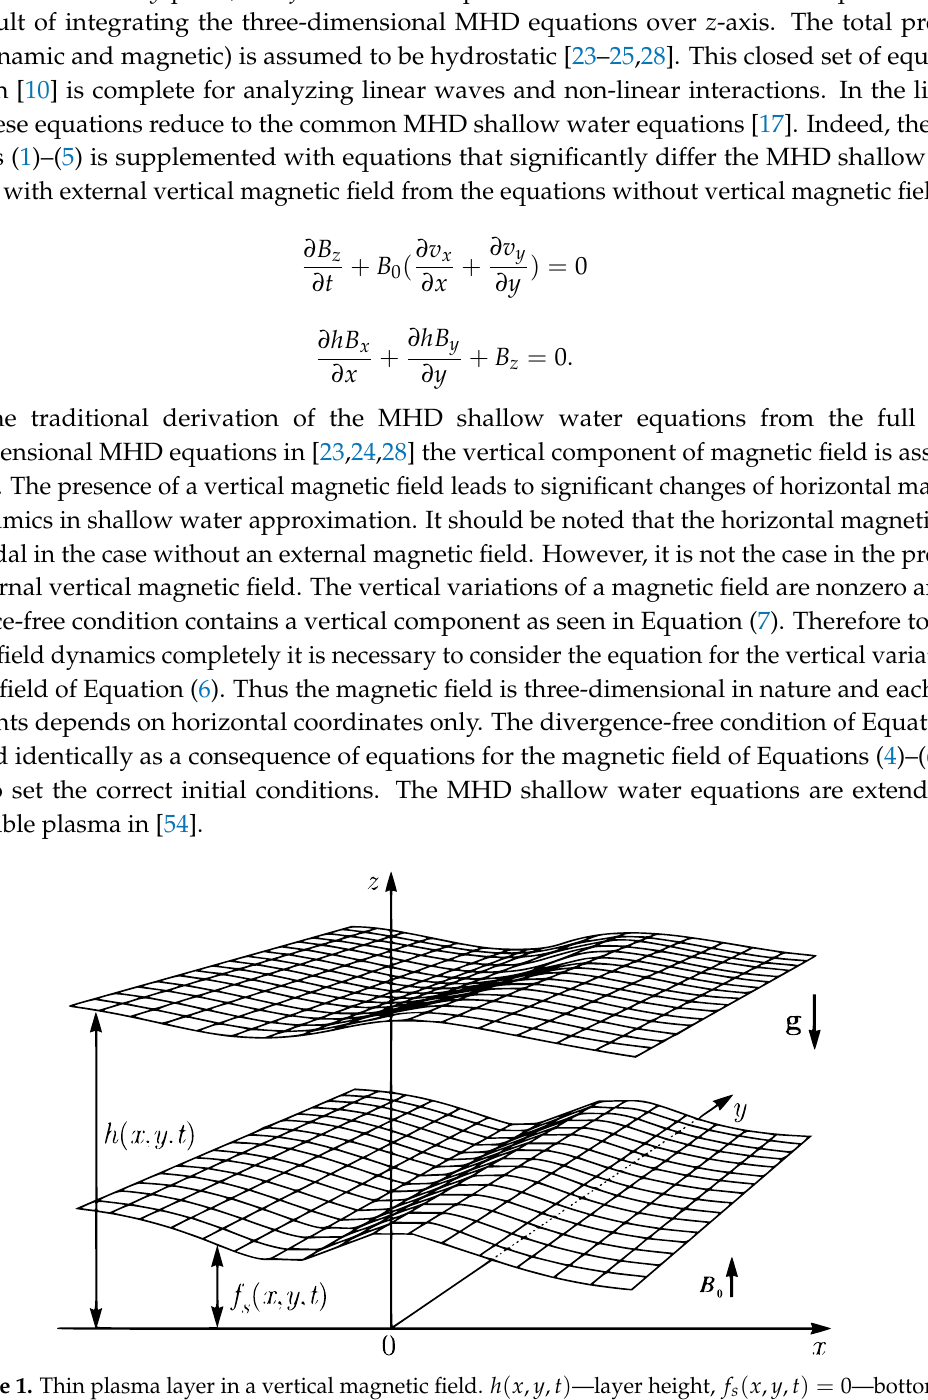
Figure 1. Thin plasma layer in a vertical magnetic field. h ( x , y , t ) —layer height, f s ( x , y , t ) = 0—bottom profile, B 0 —external vertical magnetic field, g